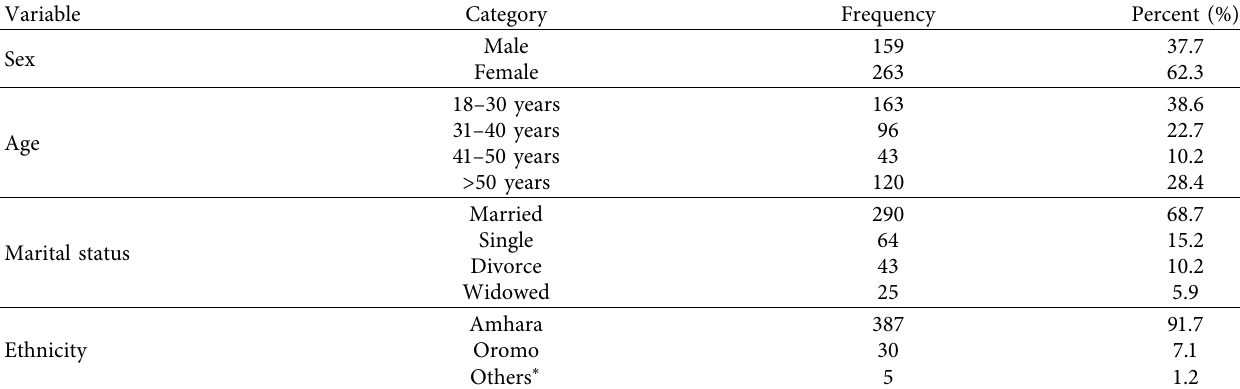
Figure 1: Schematic representation of sampling technique showing the number of selected samples from each public hospital at Dessie City Administration, 2021. Table 1: Sociodemographic characteristics of surgical patients in Dessie City Administration public hospitals, Northeast Ethiopia, 2021 ( N �